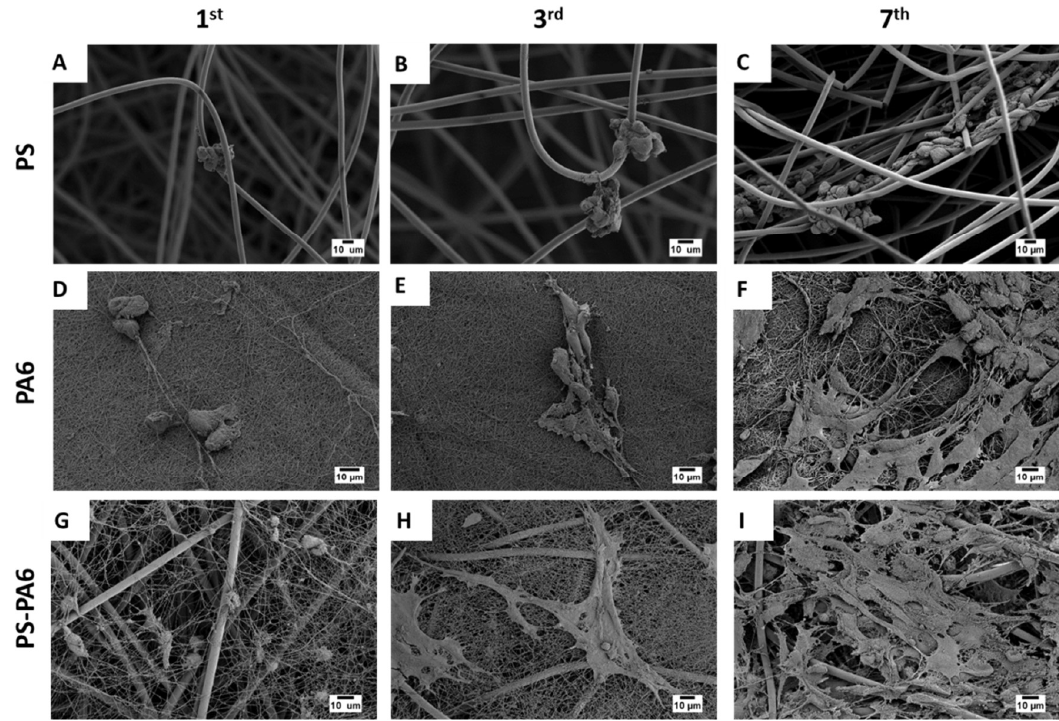
Figure 3. SEM micrographs showing fibroblasts growth on electrospun fiber after the 1st, 3rd, and 7th day in cell culture on ( A – C ) PS meshes, ( D – F ) PA6 meshes and ( G – I ) PS-PA6 composite meshes, respectively.